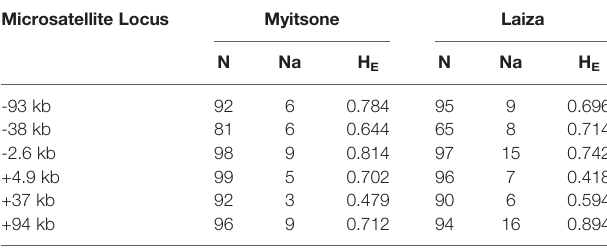
TABLE 4 | Genetic diversity measured by microsatellites in the two population of P. vivax in Myanmar. Microsatellite